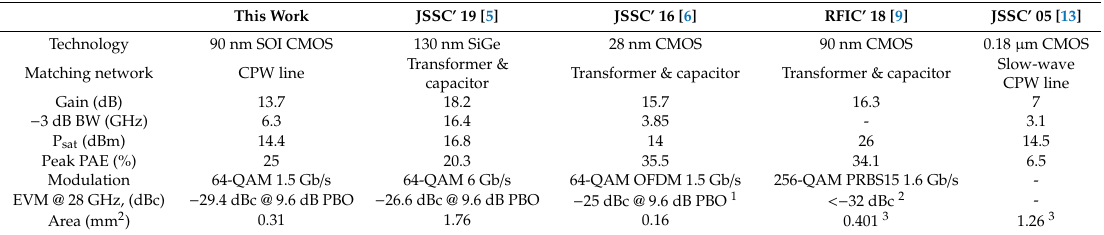
Figure 9. ( a ) EVM versus average 64-QAM output power for 250 MHz BW sig at 24/25.6/28 GHz, ( b ) EVM versus carrier frequency at 6/9.6 dB PBO, ( c ) average output power and corresponding PAE versus carrier frequency at fixed EVM of − 25 dBc.